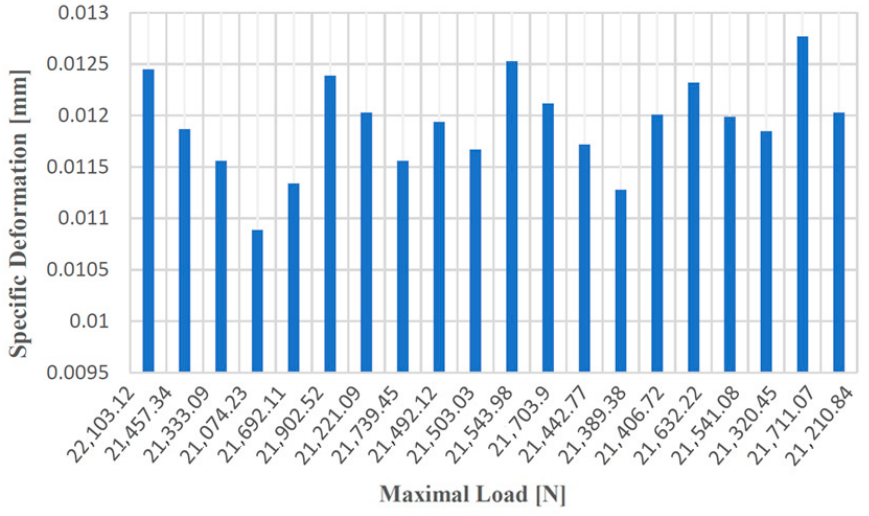
Figure 9. Values of the specific deformation according to the maximum forces applied to the 20 samples made of cast iron with lamellar graphite type EN-GJL-250.